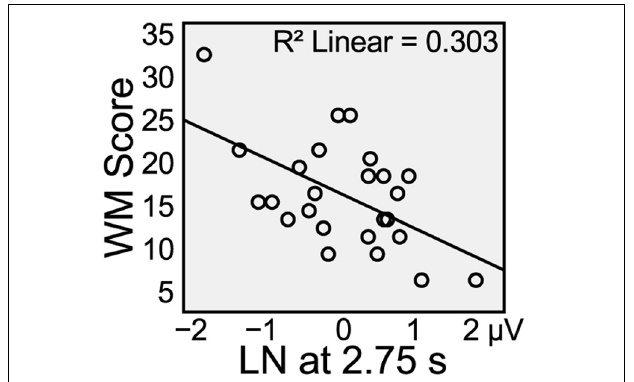
FIGURE 4 | Correlation between individual working memory span score and average difference between disagreement and agreement ERPs (left negativity, LN) at midslow left channels, 300–450ms.